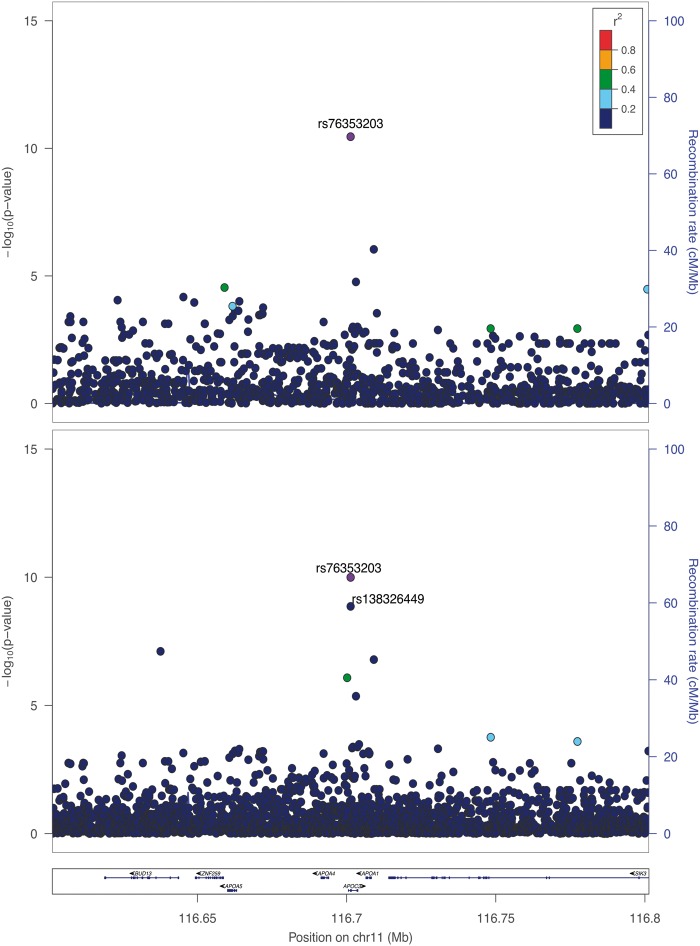
Regional association plots for TGs in the APOC3 region (n = 1225 overlapping samples). Top panel: MANOLIS GWAS data imputed up to a merged reference panel including MANOLIS, UK10K and 1000 Genomes Project WGS. Bottom panel: MANOLIS low-depth WGS data. LD values were derived using genotype data from each dataset.